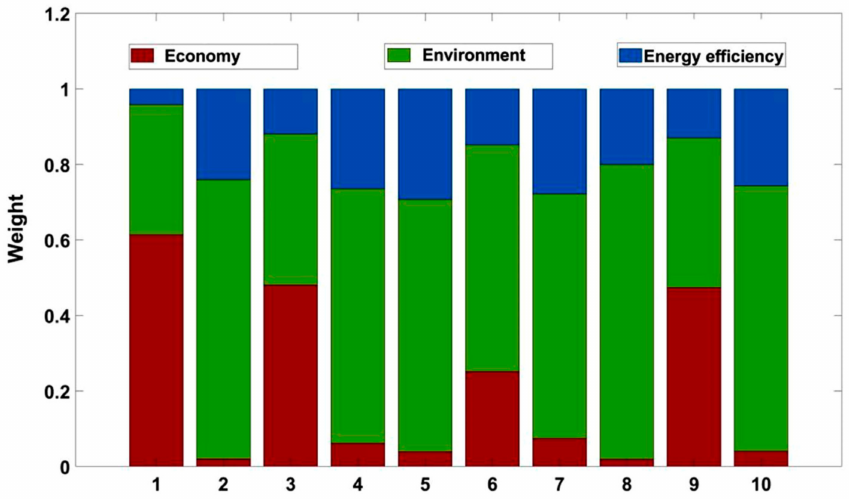
Figure 15. Objective weight comparison of NSGA-II.